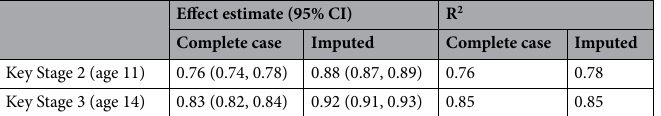
Table 1. Standardised association between achievement and teacher